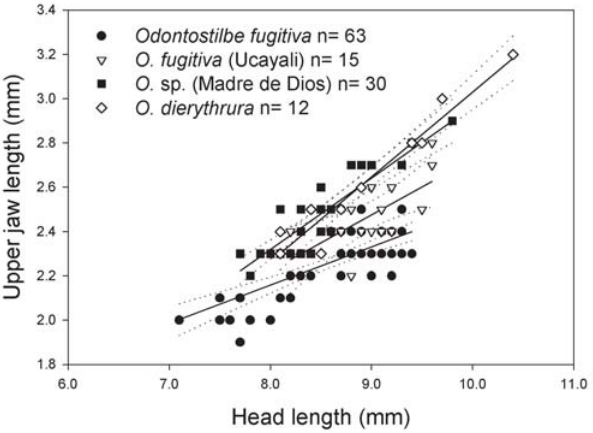
Fig 11. Upper jaw length as a function of head length for males of Odontostilbe fugitiva , specimens widely distributed on río Amazonas basin, and specimens of río Ucayali basin, against O. dierythrura and Odontostilbe sp. of río Madre de Dios basin.